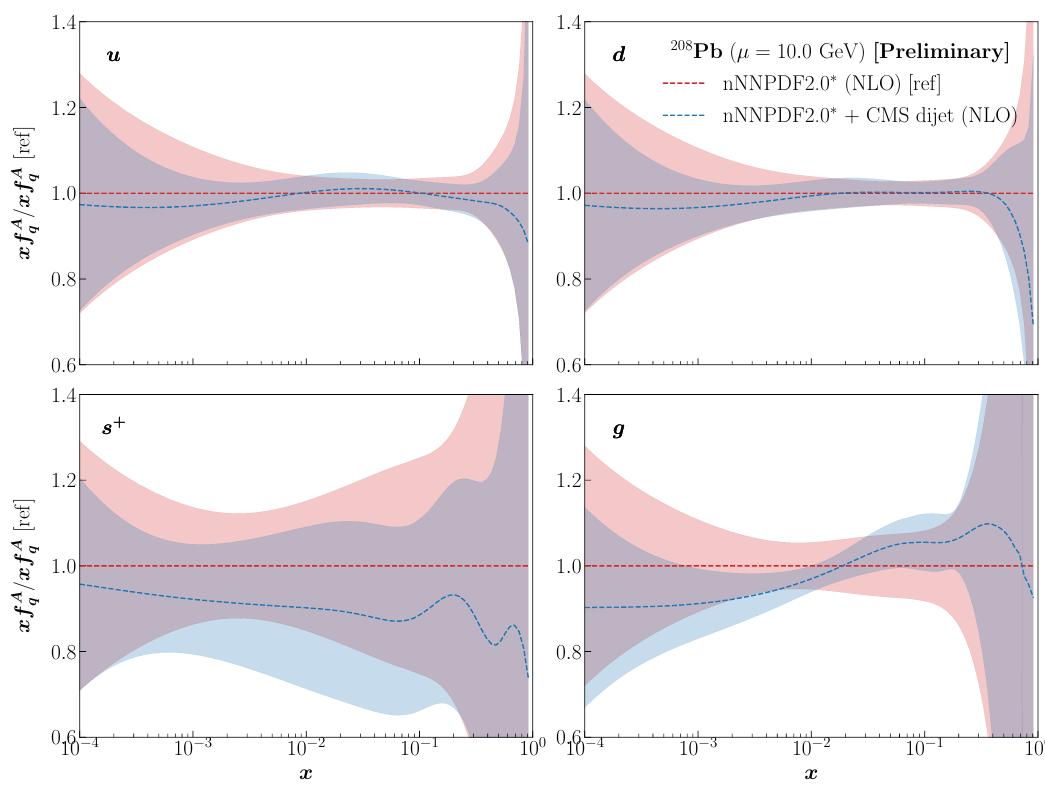
Figure 5: Comparison of the up, down, strange and antistrange combination and gluon NLO nPDFs as a ratio of a fit augmented by the CMS dijet pPb / pp data to the nNNPDF2.0-like fit with the new baseline (called nNNPDF2.0 ∗